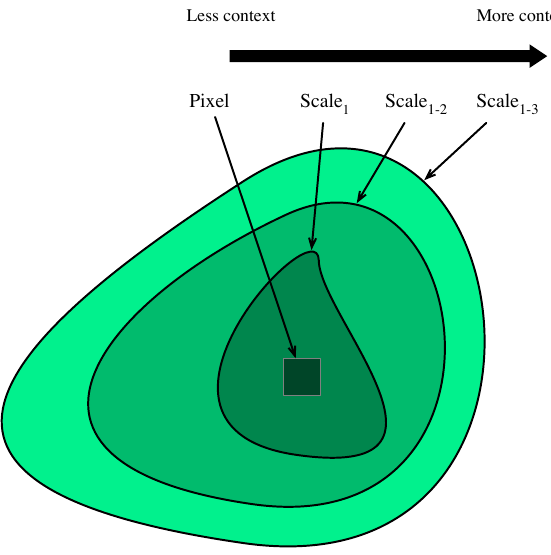
Figure 5. Information about the context of a pixel at different